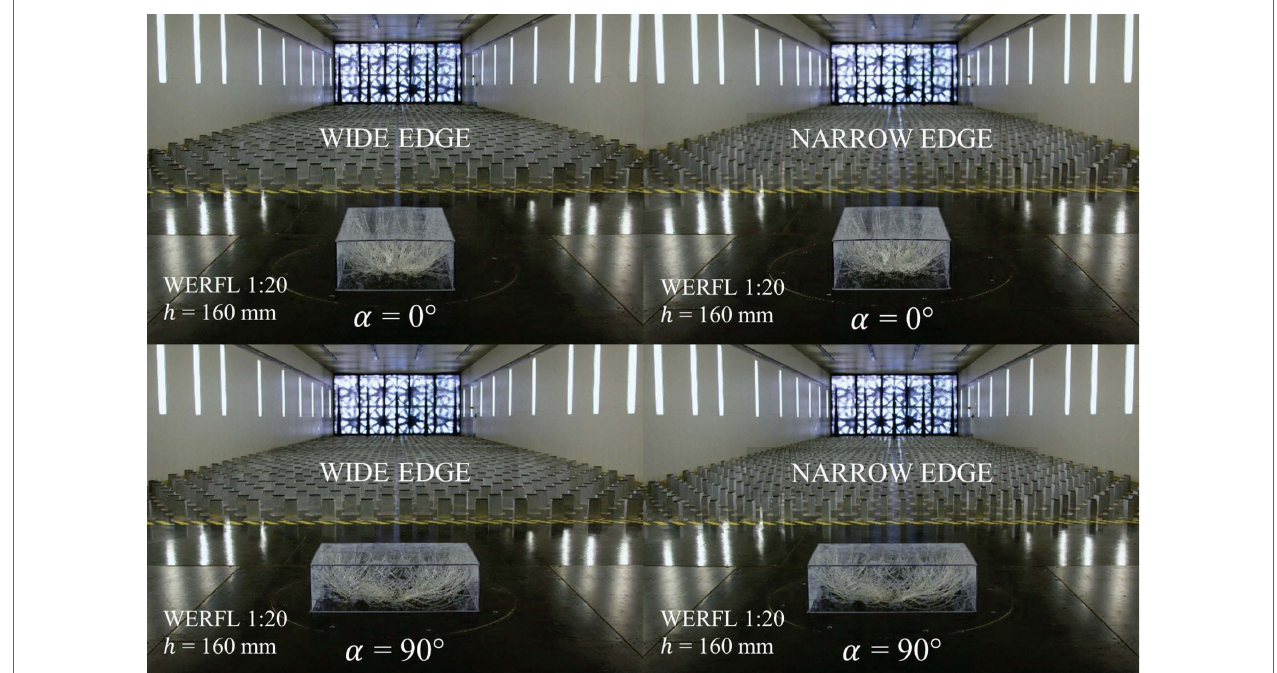
FIGURE 6 | Boundary layer wind tunnel modeling of the 1:20 Wind Engineering Research Field Laboratory (WERFL) building for the narrow and wide roughness element arrangements and the two building orientations considered in this study.